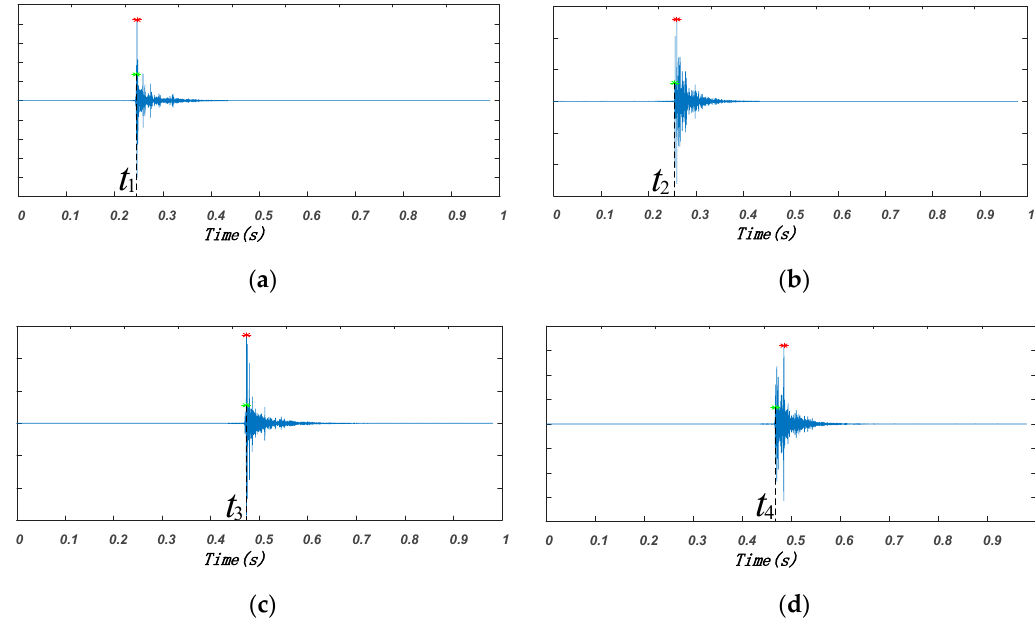
Figure 10. Estimation of arrival times for different nodes. ( a ) Cross correlation (CC) of Node 1; ( b ) CC of Node 2; ( c ) CC of Node 3; ( d ) CC of Node 4.